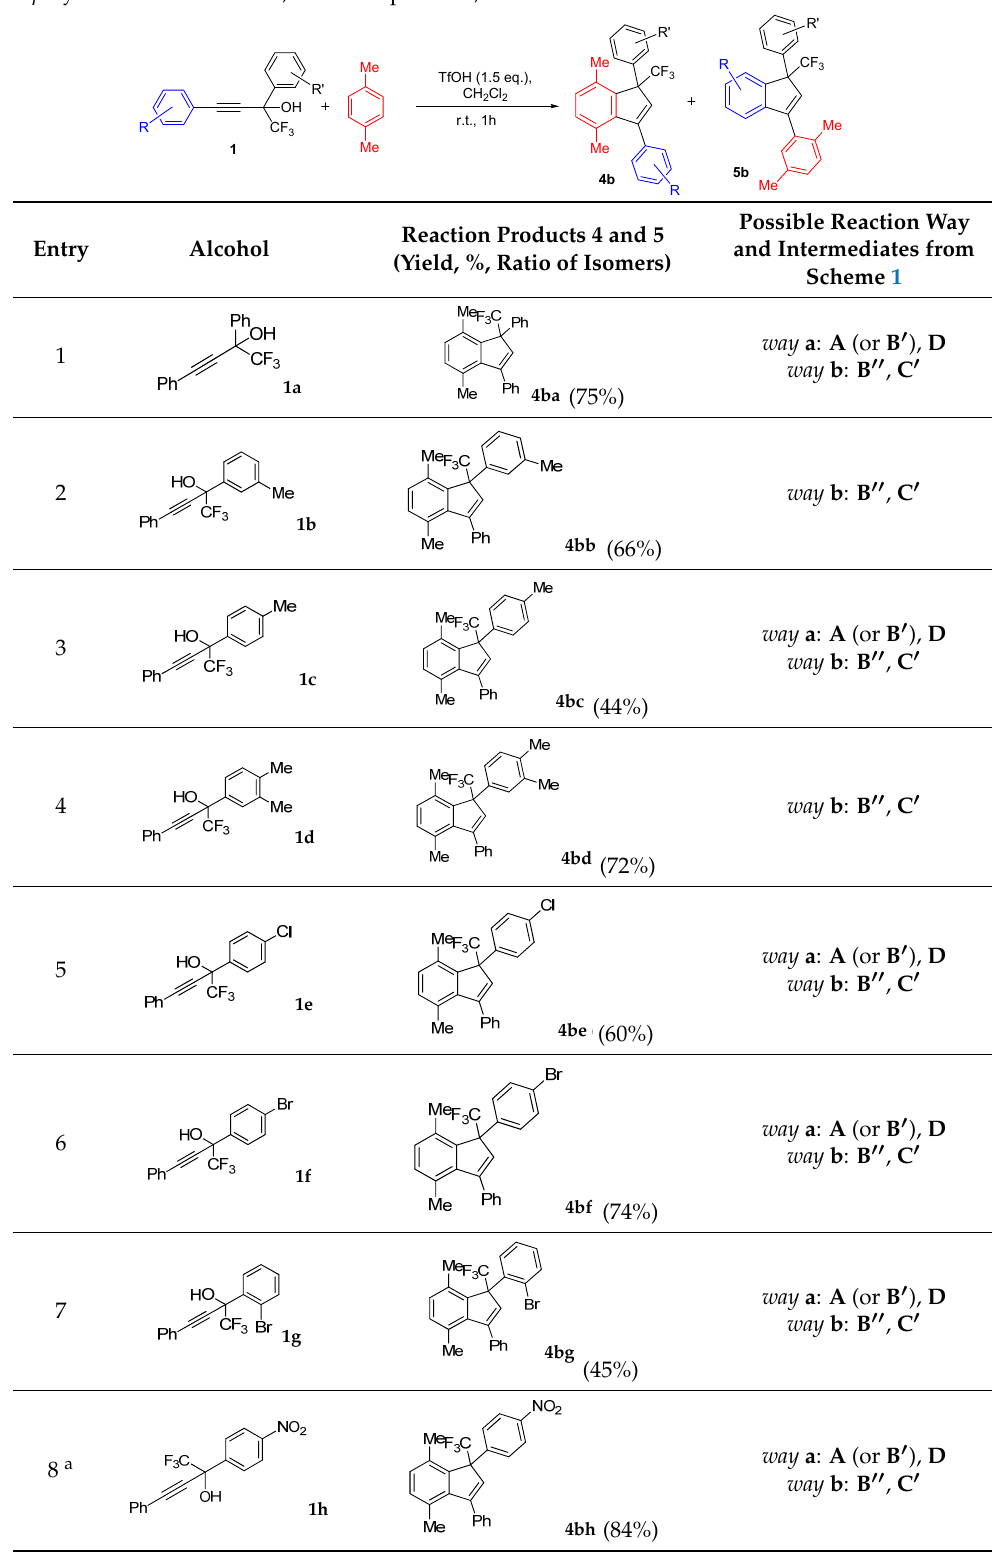
Table 4. TfOH-promoted reaction of 1 with p -xylene; reaction conditions: TfOH, CH 2 Cl 2 , molar ratio